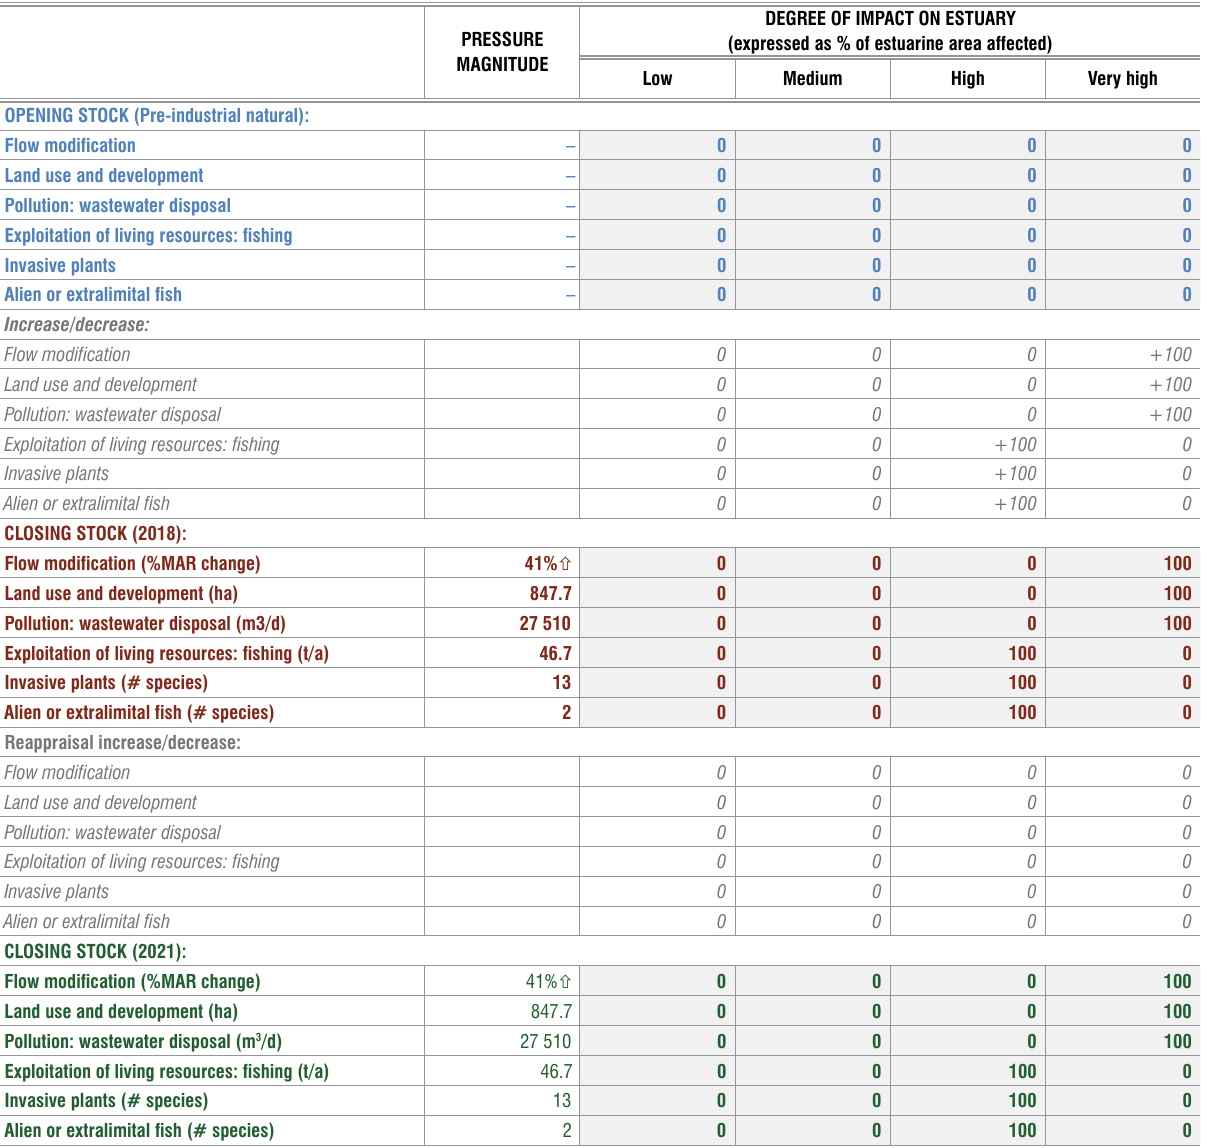
Table 6: Pressure account for the Swartkops Estuary